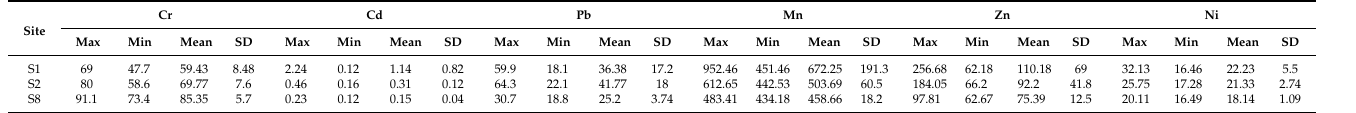
Table 3. Concentrations (mg · kg − 1 ) of heavy metals in profiled soils.